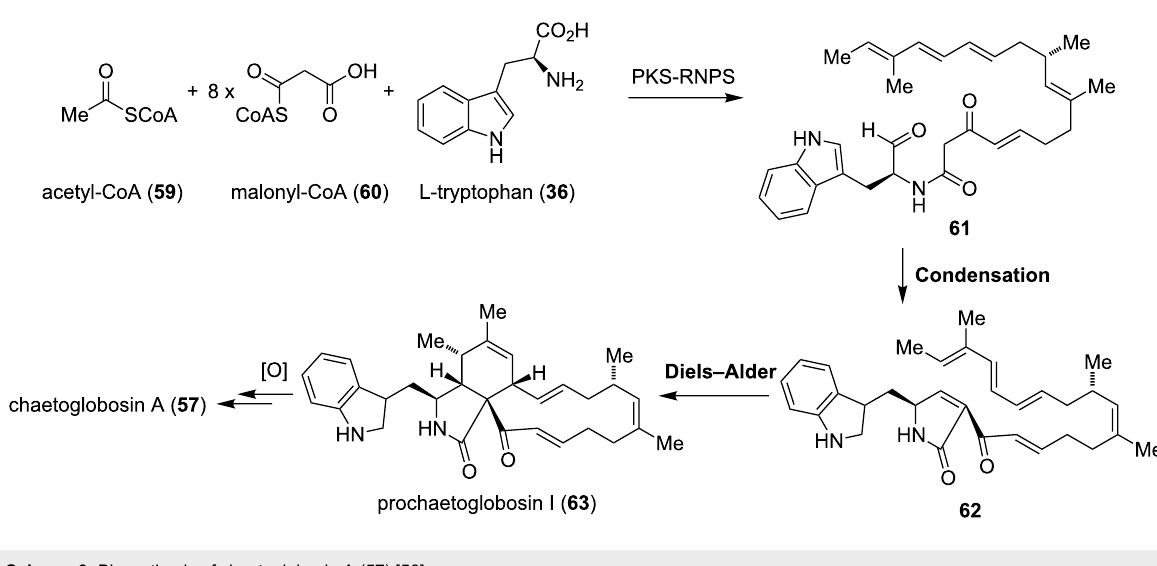
Scheme 6: Biosynthesis of chaetoglobosin A ( 57 )